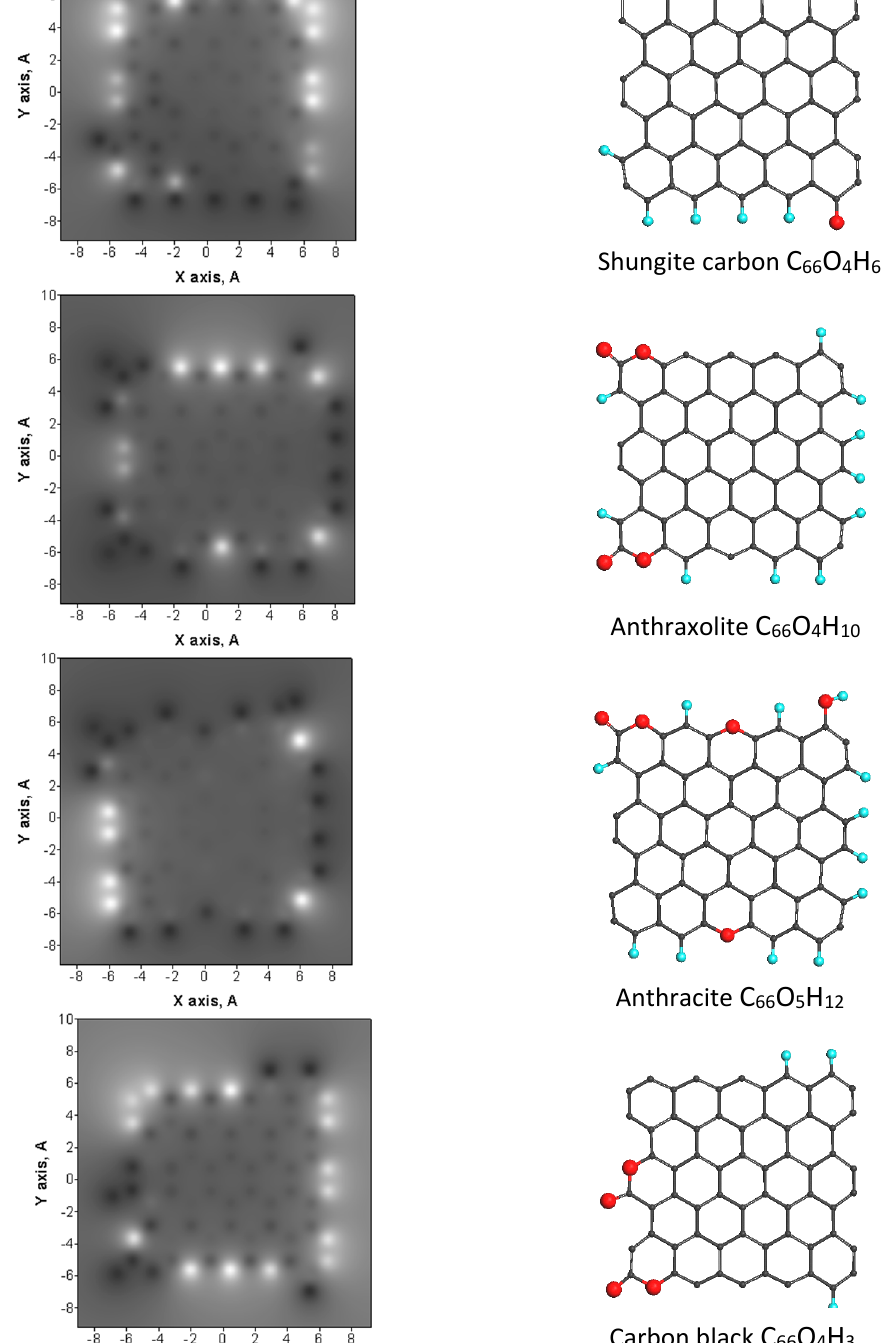
Figure 2. Figure 2. Atomic chemical susceptibility (ACS) N DA maps ( left ) and equilibrium atomic structures ( right ) of graphene oxyhydride (GOH) models of amorphous carbons. Top: ACS map and Z → A N DA distribution over atoms of the parent (5,5) nanoghraphene (NGR)